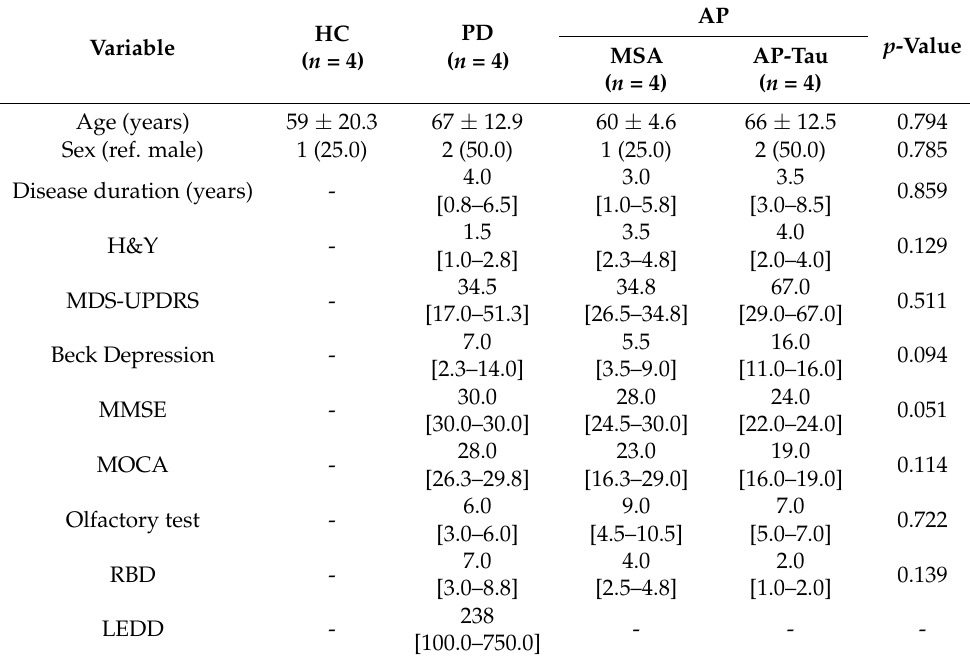
Clinical characteristics of healthy controls (HC) compared to patients diagnosed with Parkinson’s disease (PD), multisystem atrophy (MSA), or atypical parkinsonism with tauopathies (AP-Tau). Variables are reported as mean ± SD, median (interquartile range) and absolute number (percentage), as appropriate. Abbreviations: H&Y (Hoehn and Yahr scale), MDS-UPDRS (Movement Disorder Society-Unified Parkinson’s Disease Rating